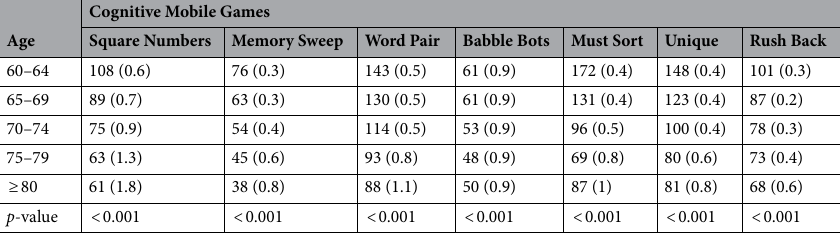
Table 2. Results of the mixed models, β (SE) representing the change of score of the CMG per session training. Models are adjusted for the total duration of the training (Supplementary Table S1).